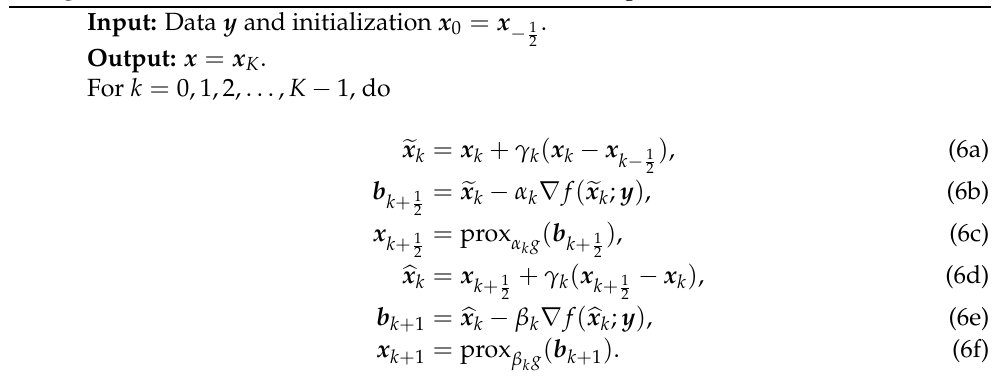
Algorithm 1: Accelerated Extra Proximal Gradient